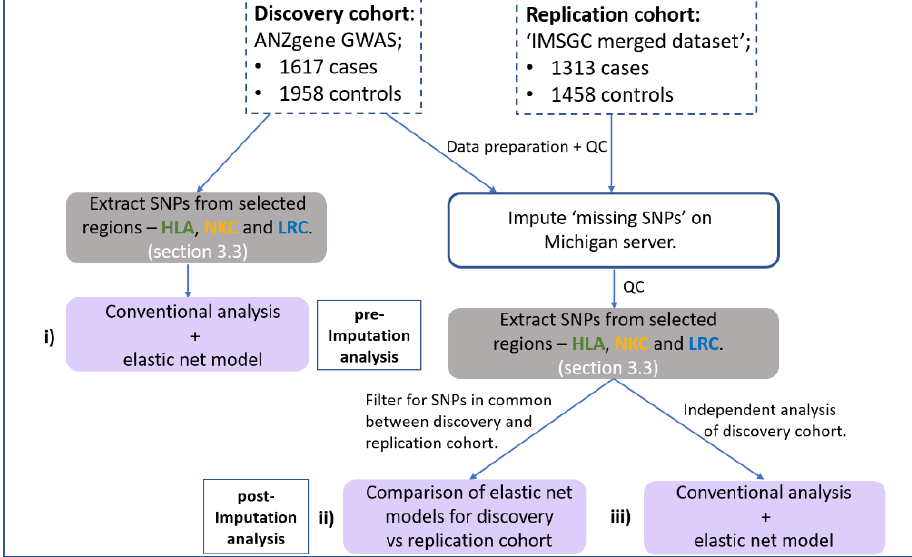
Figure 1. Flow chart outlining the major steps within the analysis pipeline. Two MS GWAS have been re-analysed. ( i ) First, the HLA and NK receptor loci were extracted from the pre-imputed discovery cohort and both a conventional GWAS and elastic net analysis performed and compared. Haploview [35] was used to determine if the SNPs identified by elastic net were in disequilibrium. Secondly, both the discovery and replication cohort were imputed using the Michigan server with resulting SNPs subject to a stringent imputation quality control (QC) threshold (R 2 < 0.8) and extraction of SNPs from the same HLA and NK receptor genetic boundaries. ( ii ) Then, an overlapping elastic net analysis was performed on SNPs in common between the discovery and replication cohort that met imputation QC threshold. ( iii ) Thirdly, an in-depth independent analysis on the imputed discovery cohort was performed to maximise coverage of high-quality imputed SNPs. Grey boxes indicate the stage of SNP extraction across the three regions, and purple boxes indicate the three different combinations of datasets and SNPs being analysed.